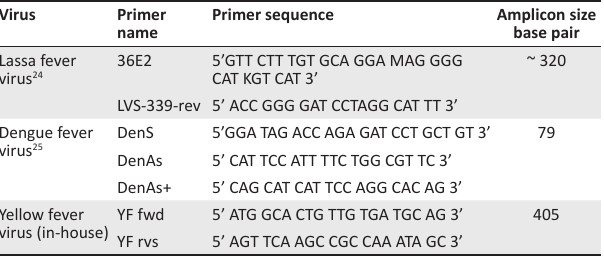
TABLE 1: Primers used for Lassa, Dengue and yellow fever investigation, Lagos, Nigeria, March 2018.